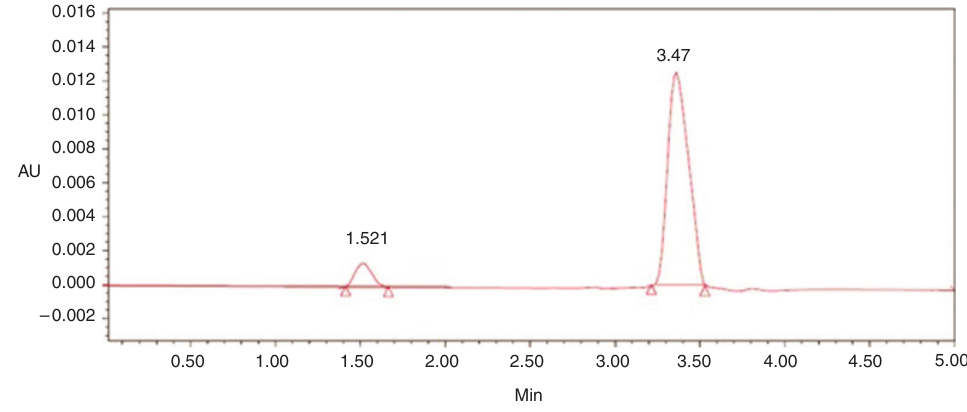
Figure 6: HPLC chromatogram of rosuvastatin under thermal